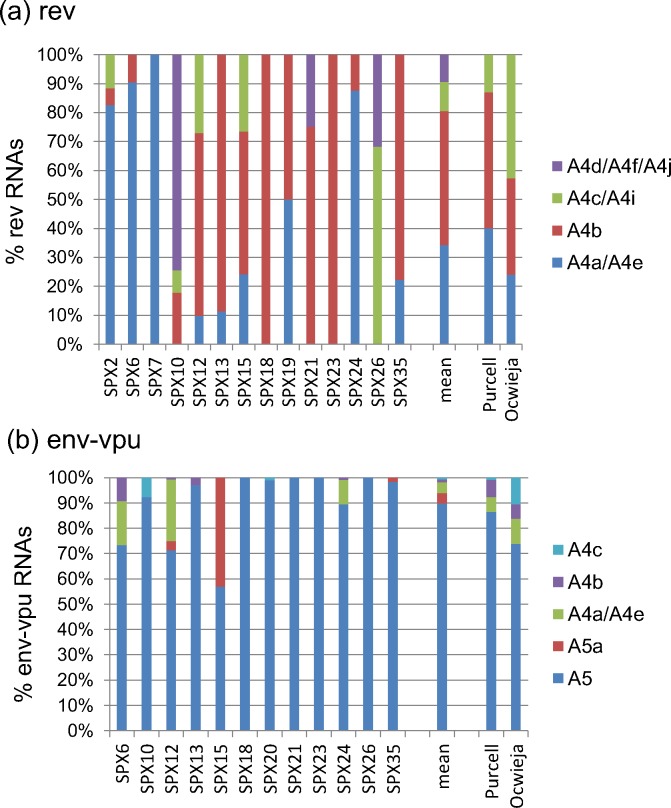
Alternative 3’ss usage by (a) rev and (b) env-vpu RNAs. 3’ss separated by one or two nt (A4a/A4e, A4c/A4i, A4d/A4f/A4j) were grouped together. A4e is used by SPX24 and SPX35, A4d by SPX26, A4f by SPX10, A4j by SPX21, and A4i by SPX12. The vertical axis represents proportions of RNAs using each 3’ss relative to all transcripts of each class. Mean proportions of all samples are shown on the right of the columns for individual samples. For comparison, proportions reported in in vitro studies by Purcell and Martin [6] and Ocwieja et al. [9] are shown.